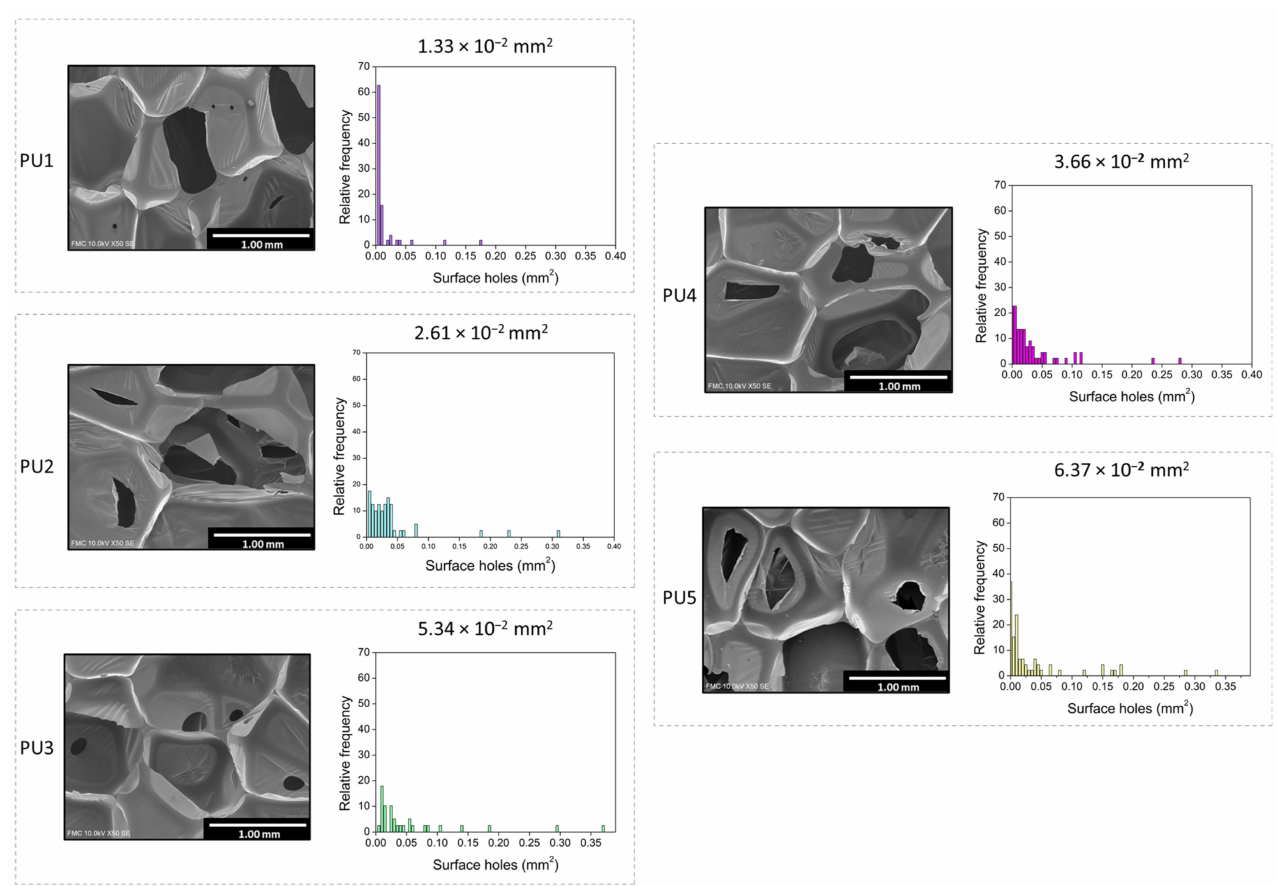
Figure 4. Surface hole distribution for each sample and micrographs for representative holes in the cell